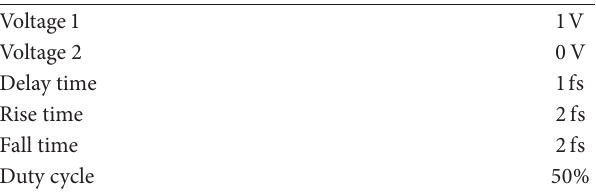
Table 2: Square wave input